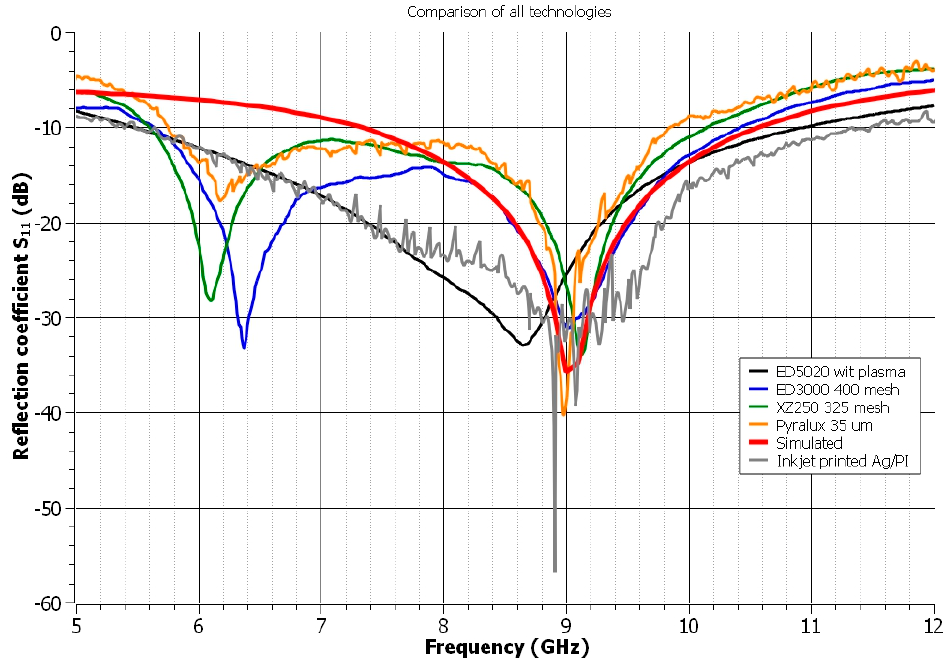
Figure 8. The reflection coefficient of all analyzed materials—selection of the best solutions.